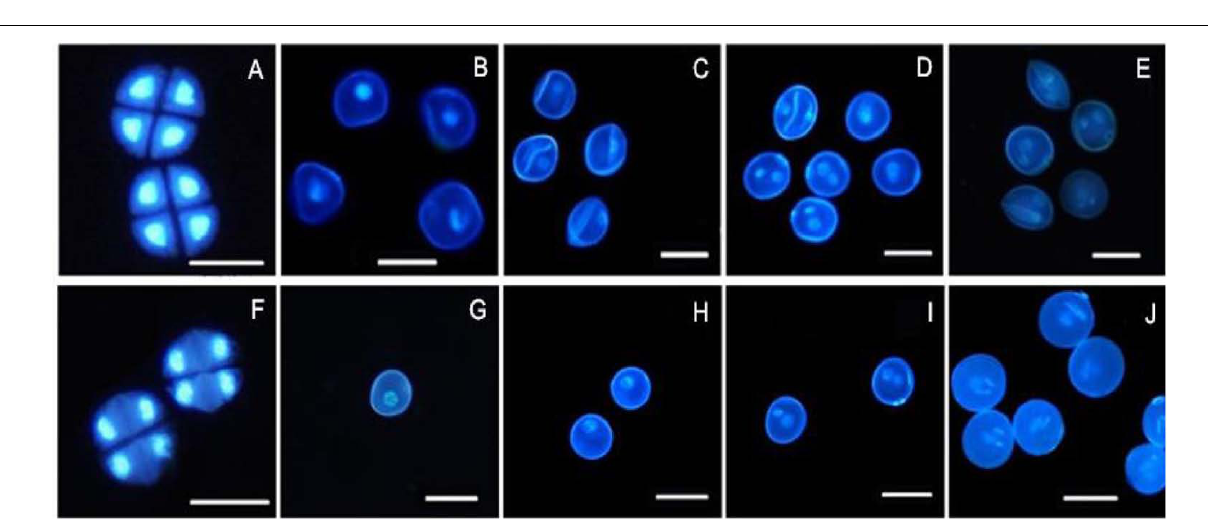
FIGURE 2 | Comparison of DAPI-stained of pollen of KTM3315A under the different fertility condition (AS: A–E, AF: F–J). (A,F) Tetrad stage; (B,G) early uninucleate stage; (C,H) the later uninucleate stage; (D,I) the binucleate stage; (E,J) the trinucleate stage. Bar: 50 µ m.